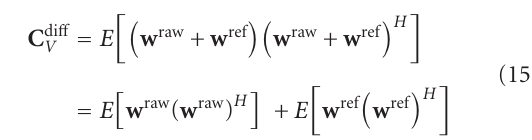
Equation (13) shows that the noise (or errors) in the mea- sured visibilities can be transferred to the inverted